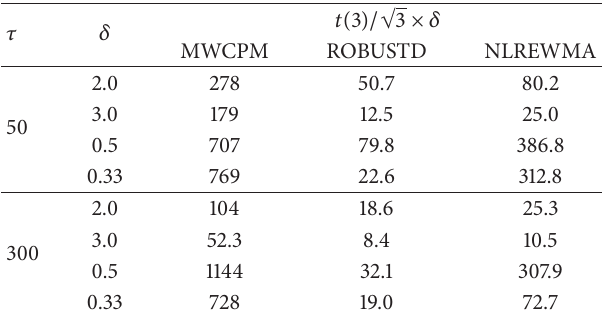
Table 3: ARL 1 (𝛿) for dispersion shifts in the heavy tailed distribu- tion 𝑡(3) , for several values of the change time 𝜏 .